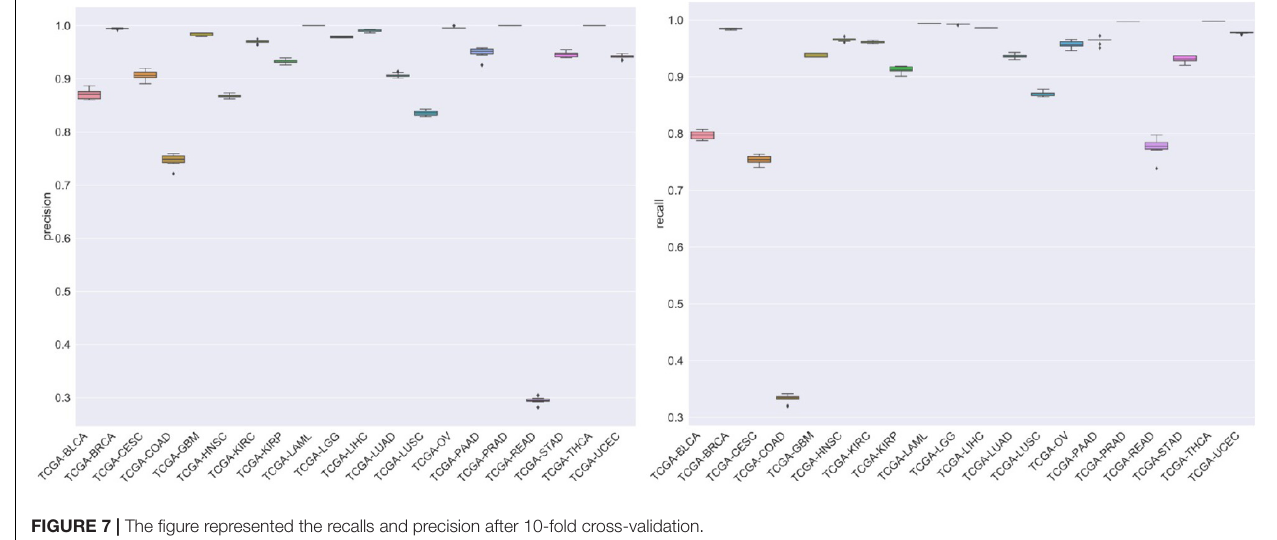
FIGURE 7 | The figure represented the recalls and precision after 10-fold cross-validation.